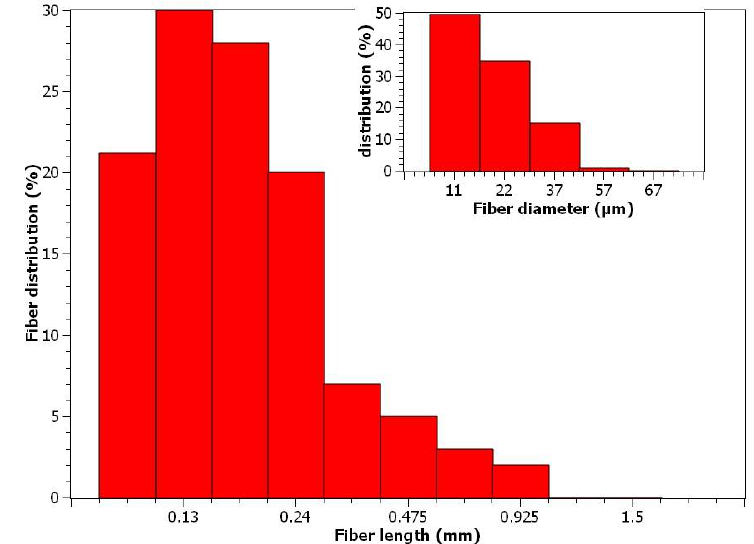
Figure 4. Distribution of the lengths and diameters of the BKHF, extracted from a composite with a 30% w / w reinforcement content.